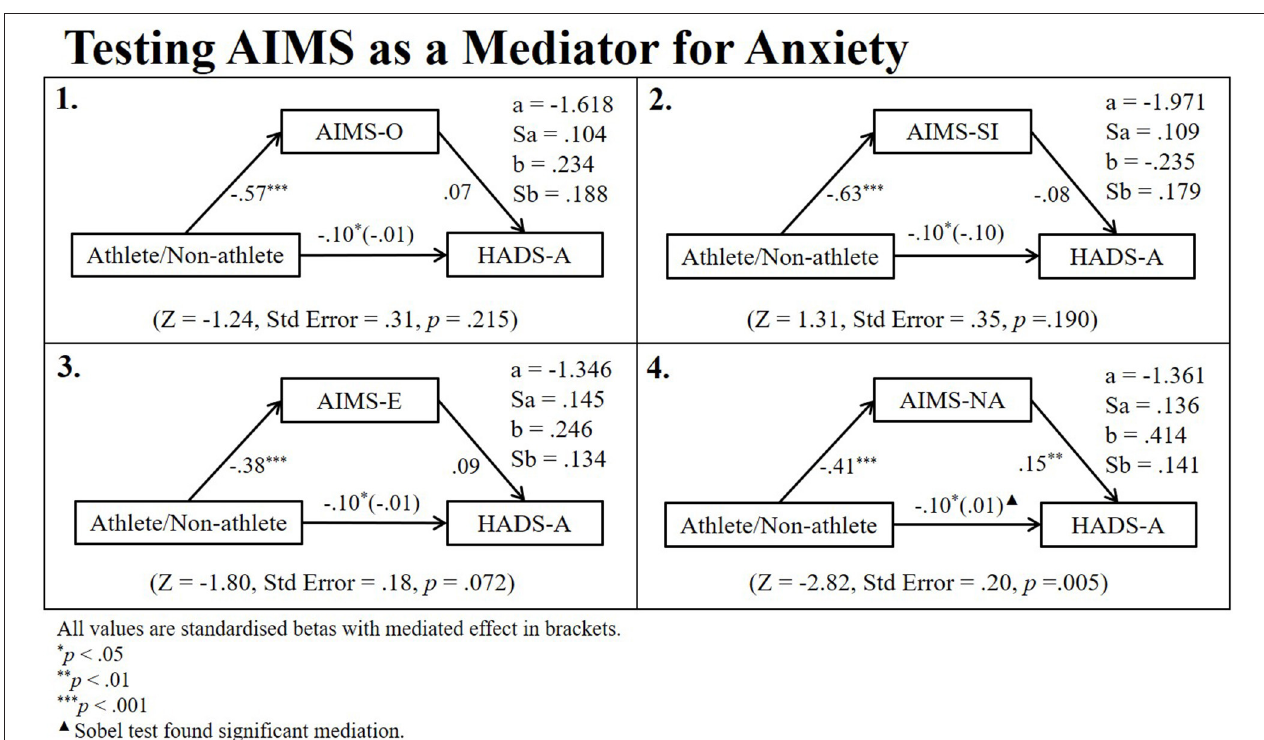
FIGURE 6 | Regression path diagrams testing aims as mediators for the difference in athlete and non-athlete